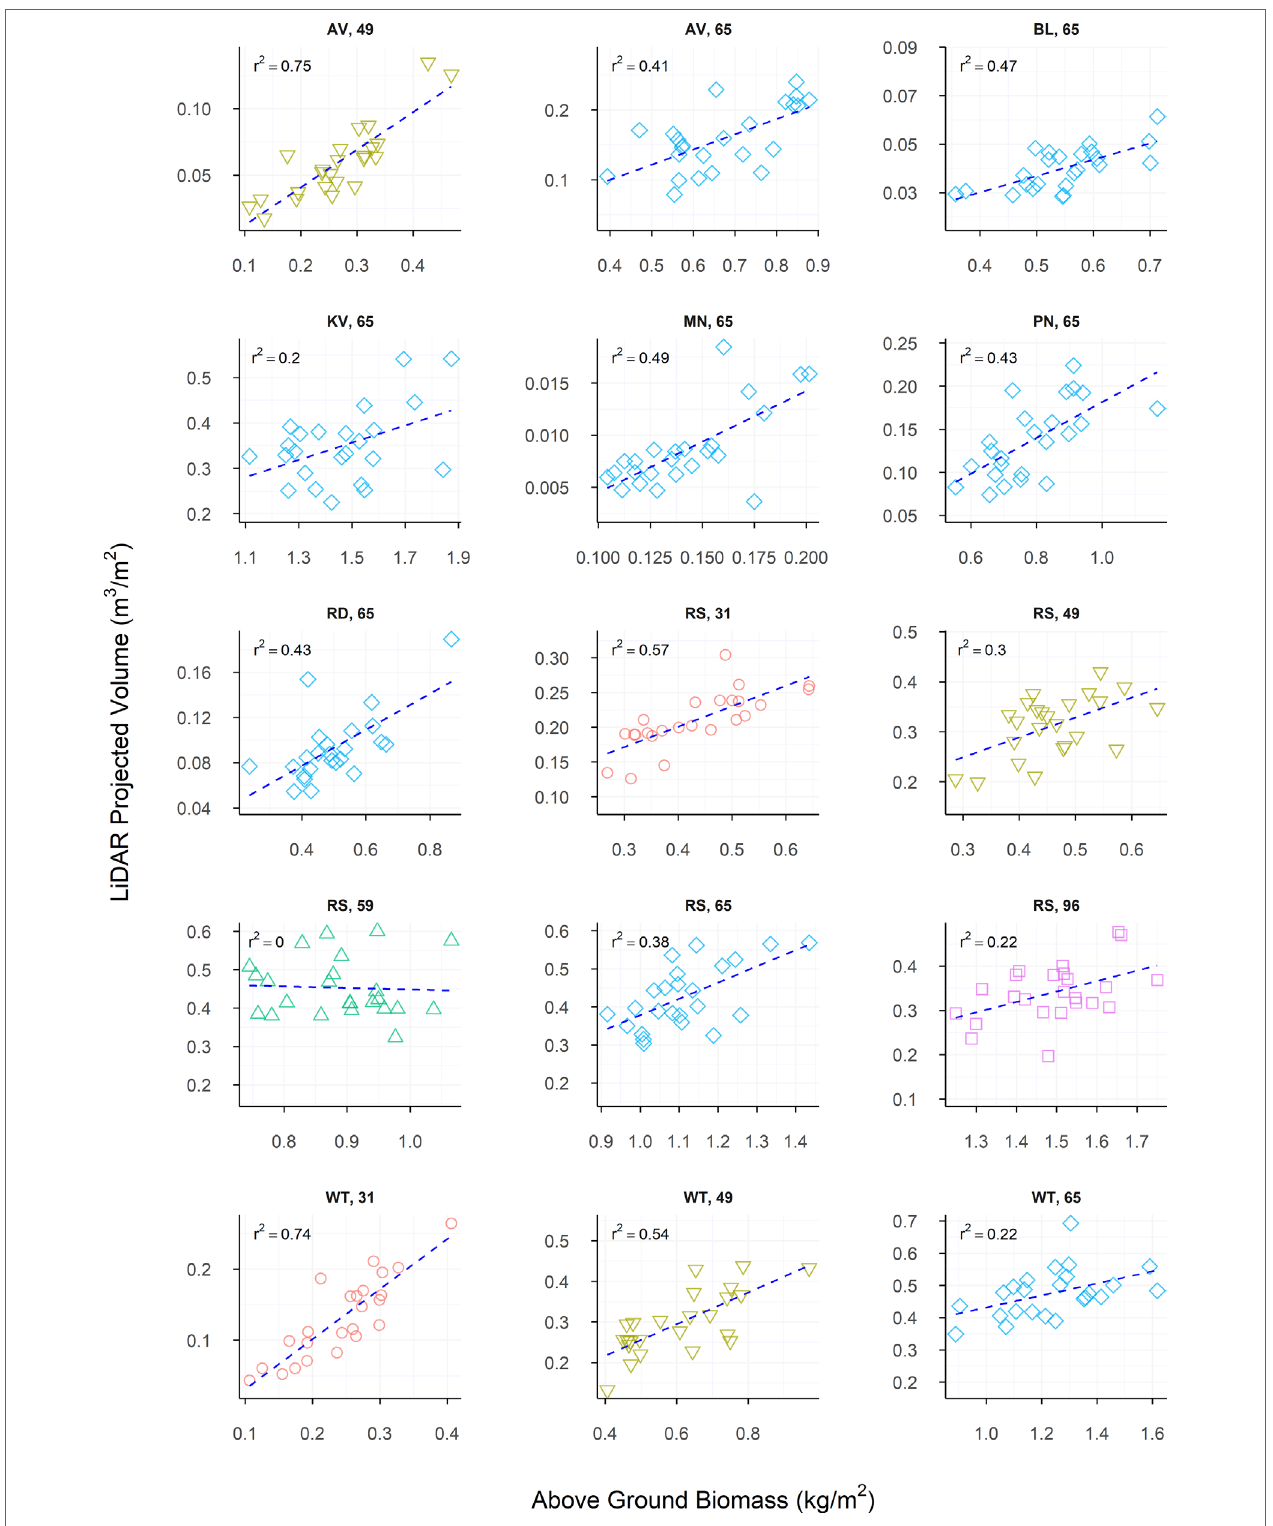
FIGURE 7 | The relationship between LiDAR Projected Volume and Above-ground Biomass, presented individually for each site and sample time measured in the current study. Dashed lines indicate the line of best fit, coloured shapes indicate measurements collected at Zadoks growth scales (ZGS) as follows, red circles at ZGS 31, yellow triangles at ZGS 49, green triangles at ZGS 59, blue diamonds at ZGS 65 and pink squares at ZGS